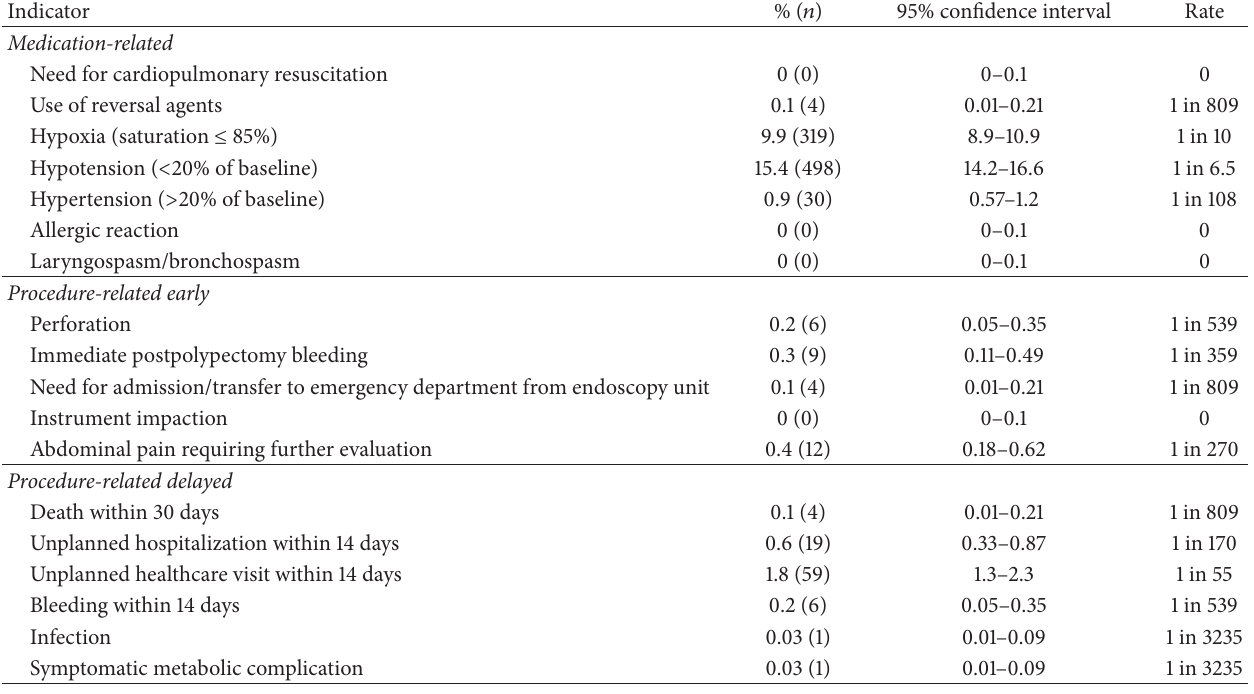
Table 2: Adverse events following